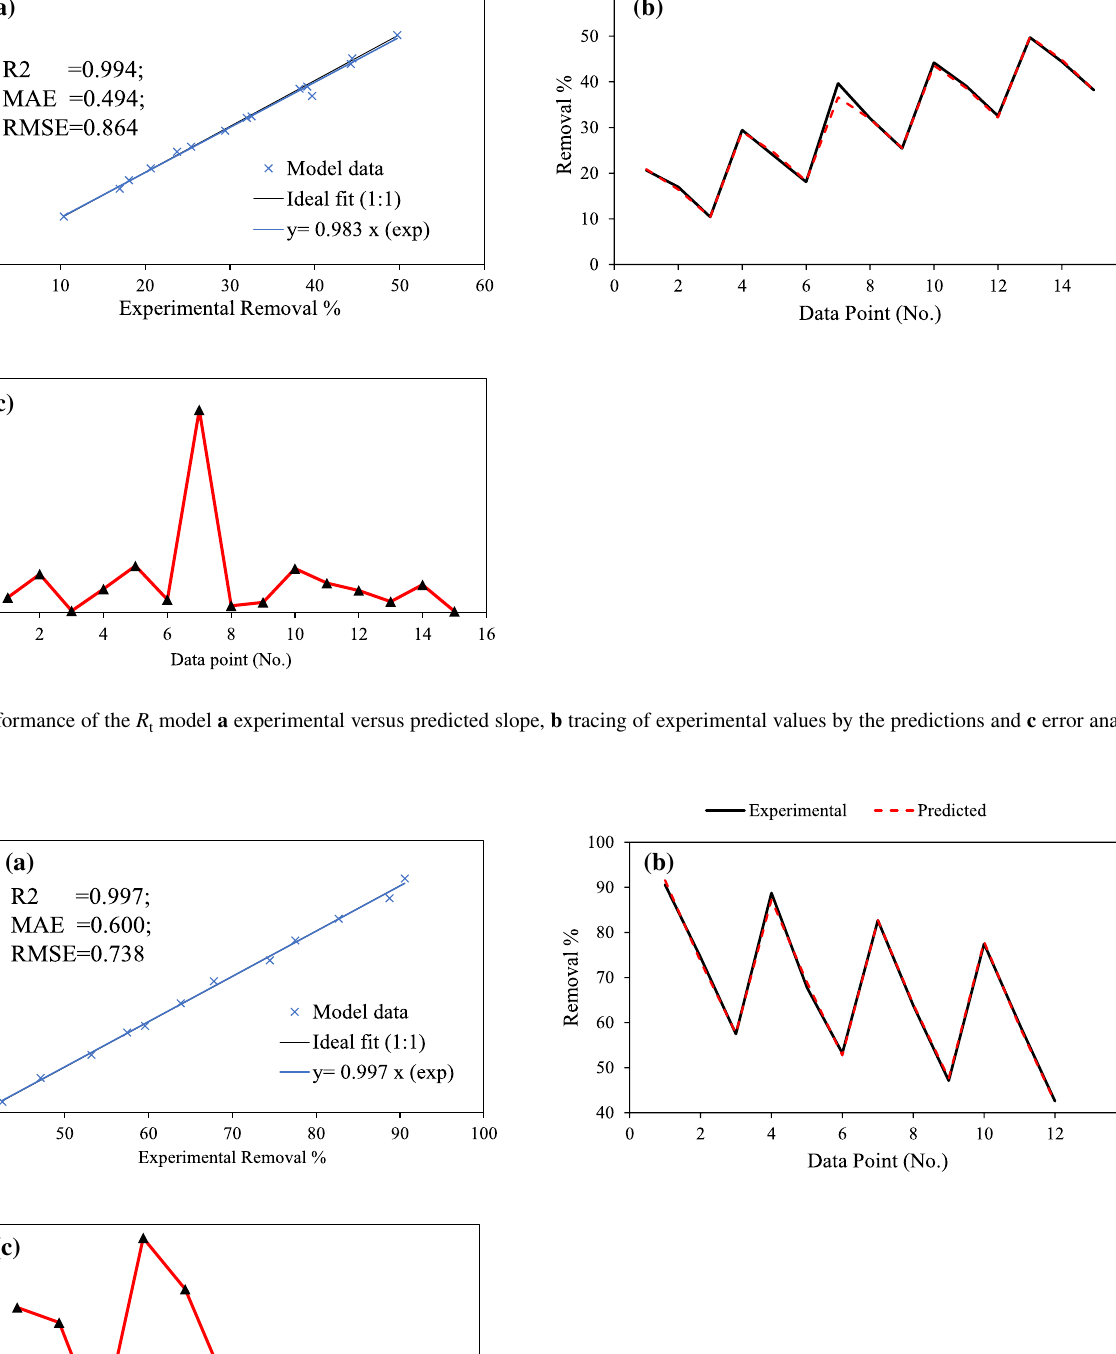
pH model a experimental versus predicted slope, b tracing of experimental values by the predictions and c error